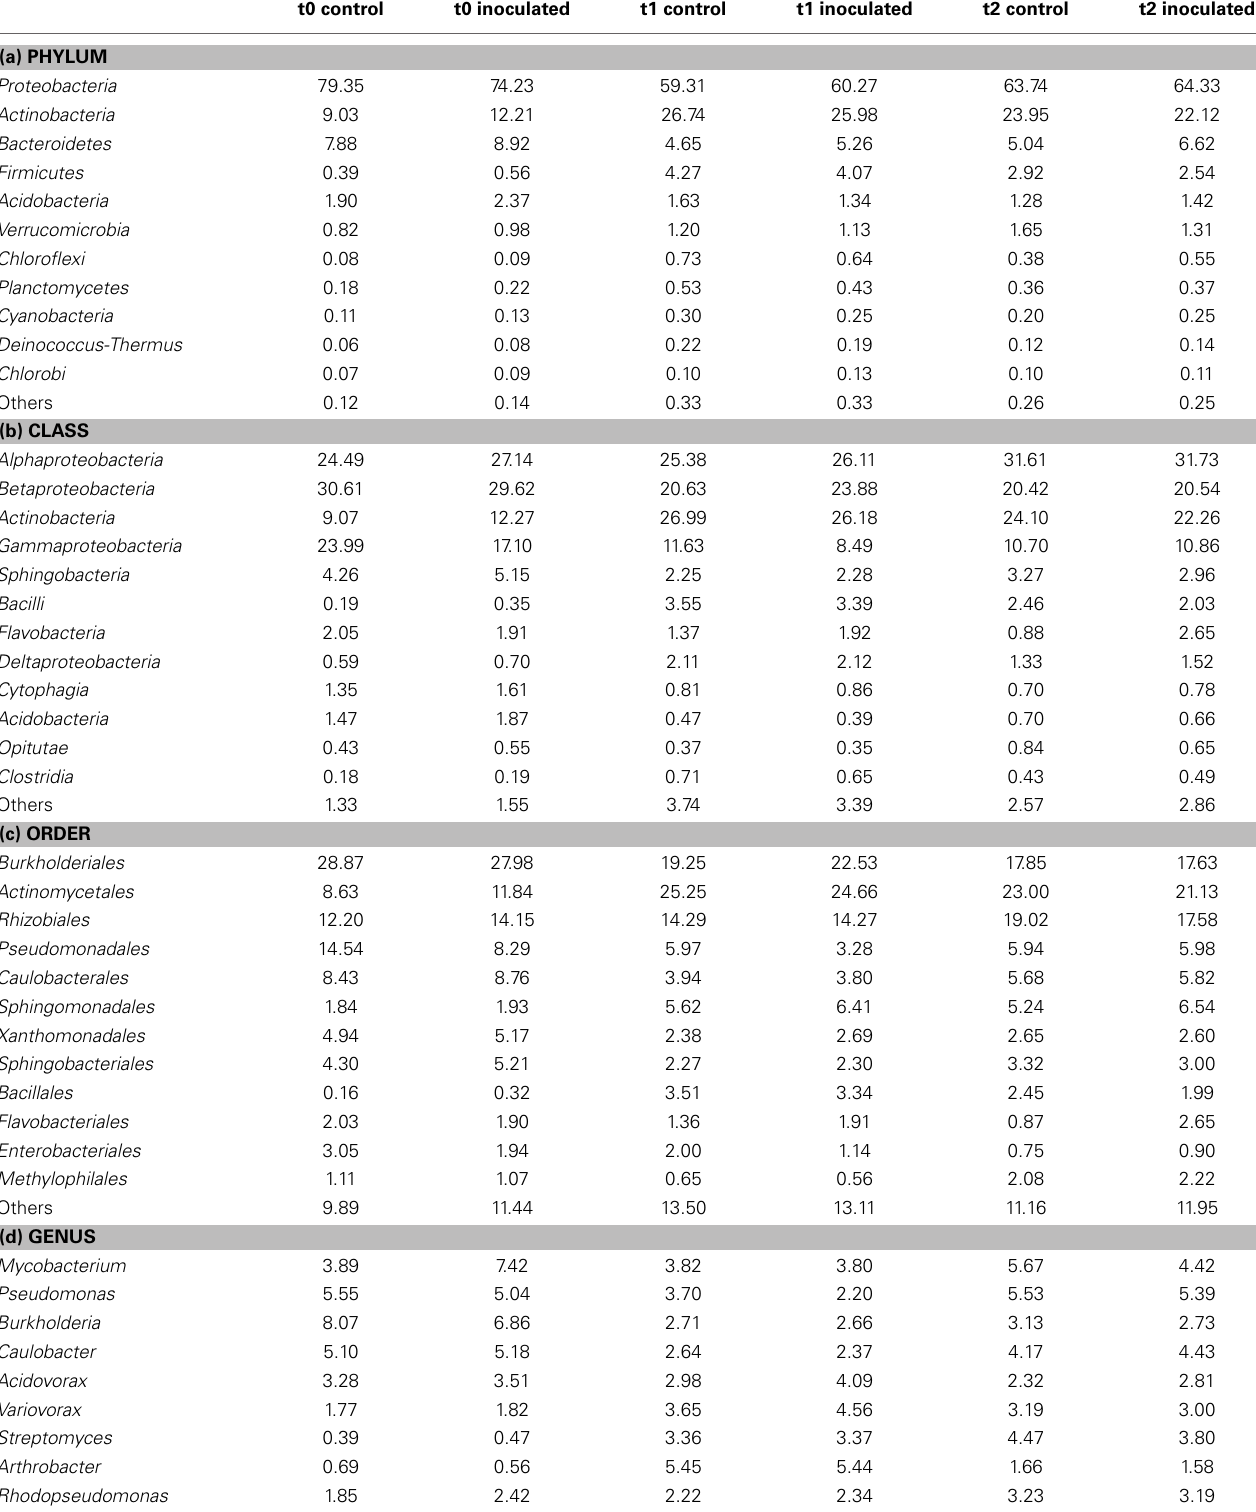
Table 5 | Relative abundances of the dominant bacterial phyla (a), classes (b), orders (c), and genera (d) within the rhizosphere of L. sativa calculated for all classified sequences within the bacterial